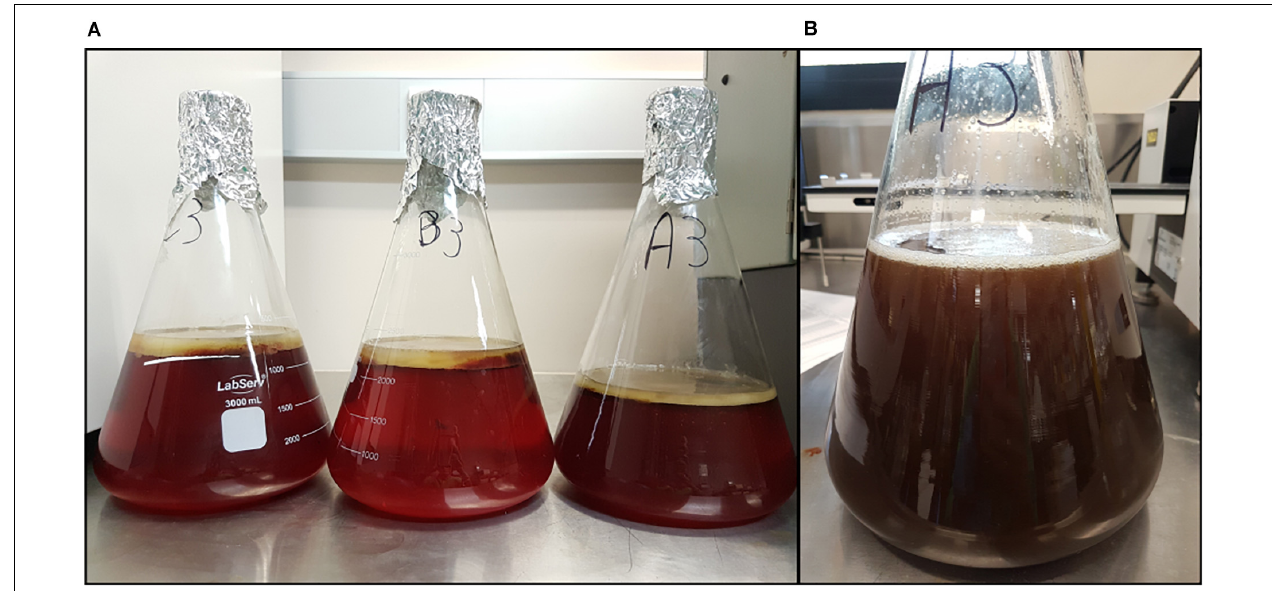
FIGURE 4 | Saponified and resuspended samples of barramundi ( Lates calcarifer ) viscera (Experiment C) after digestion with 10% potassium hydroxide (KOH) at 40 ◦ C for 3 days, (A) samples showing the formation of a white gel floating on top of the KOH digested tissue (brown underlaying liquid), gel is approximately 2 cm thick, and (B) the same sample after the addition of ethanol (1:4), the floating gel is completely resuspended.